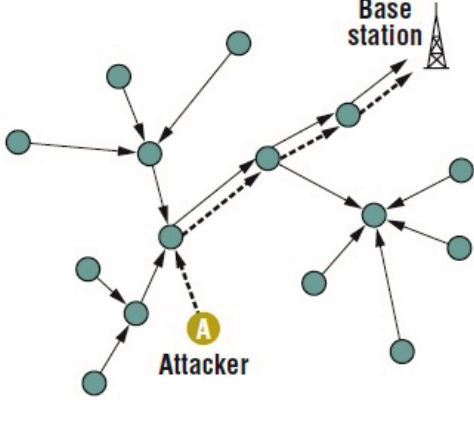
Figure 1. Selective Forwarding Attacks-Redrawn